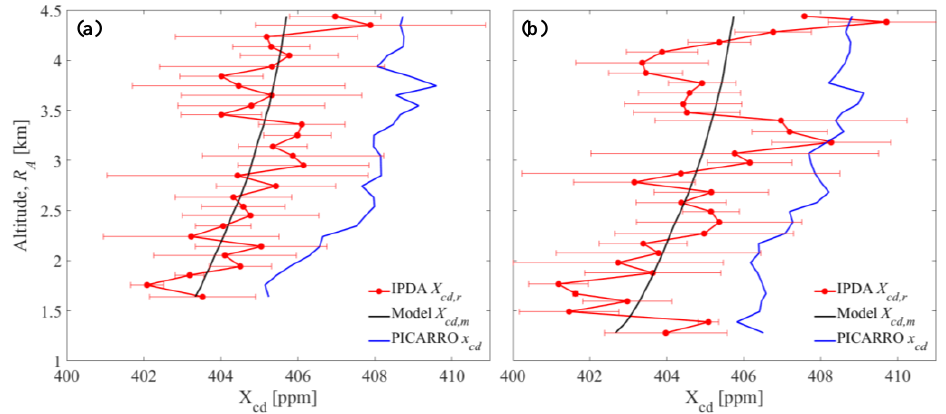
Figure 19. Airborne pulsed 2-μm IPDA lidar X cd,r retrieval enhanced using 200-m range-bin average for ( a ) Spiral 1 before sunset and ( b ) Spiral 2 after sunset. Horizontal bars indicated retrieval standard deviation within each range-bin. Results are compared to MGD model, X cd,m , and in situ measurements x cd .